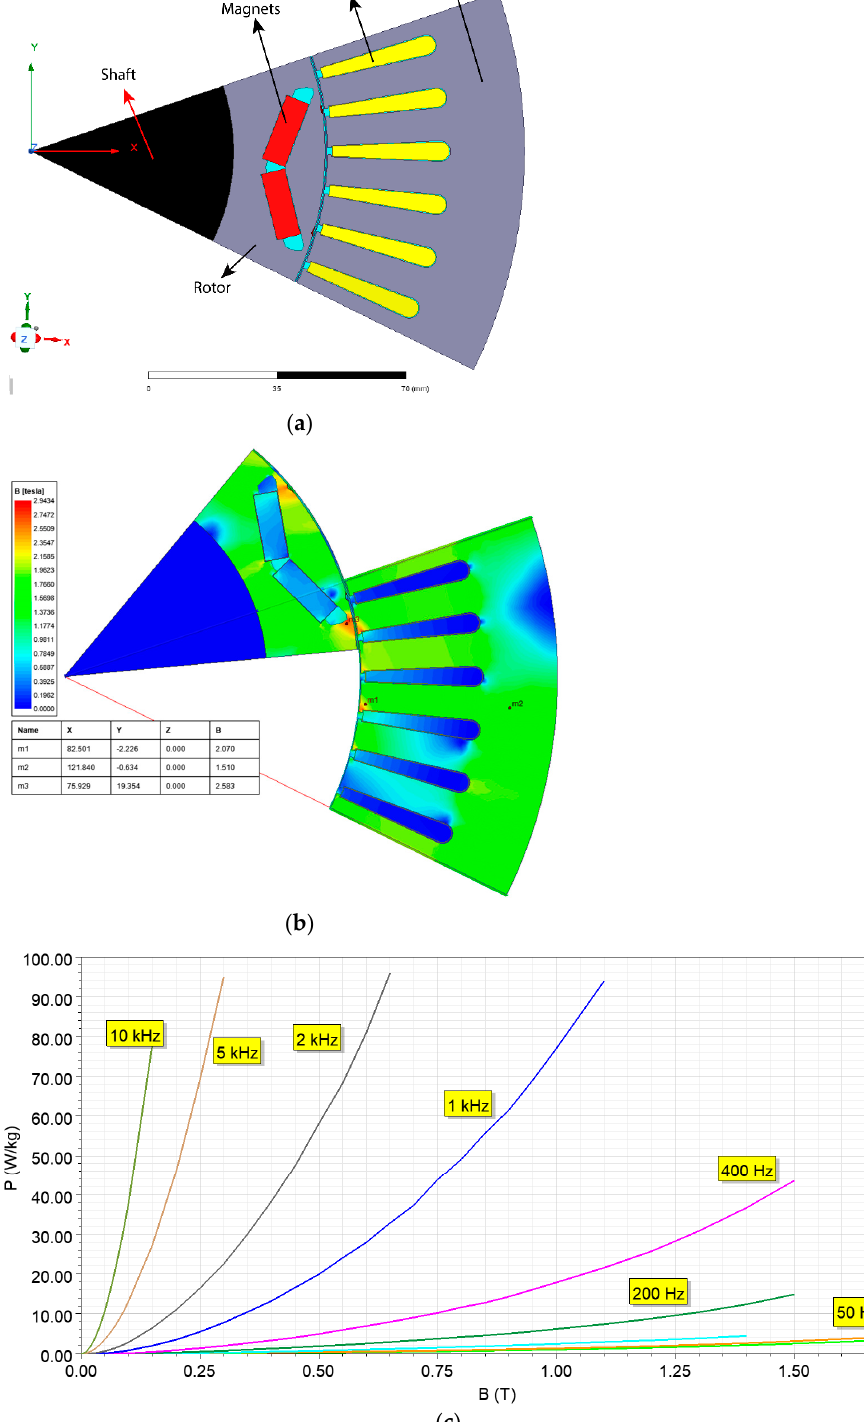
Figure 1. Analyzed motor for the 2D FEM: ( a ) motor geometry; ( b ) magnetic flux density distribution; ( c ) core loss versus frequency for JFE_Steel_35JN300. Table 1. Design specifications of used motor.